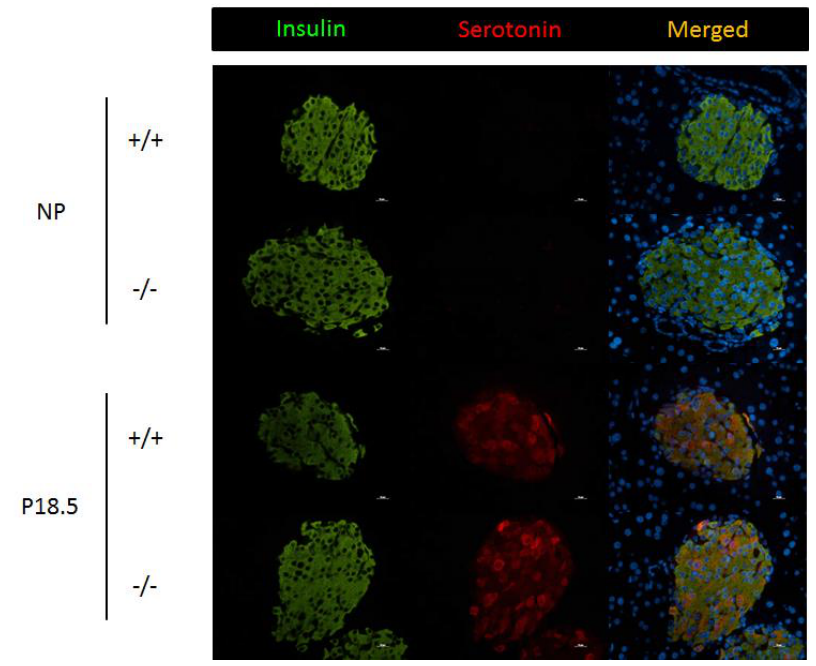
Figure 9. Serotonin immunoreactivity in pancreatic islets from non-pregnant (NP) and pregnant (P18.5) wild type (+/+) and Htr2b −/− mice ( − / − ). Pancreatic sections were stained for insulin (green), serotonin (red), and DAPI (blue). Scale bars 10 µm.